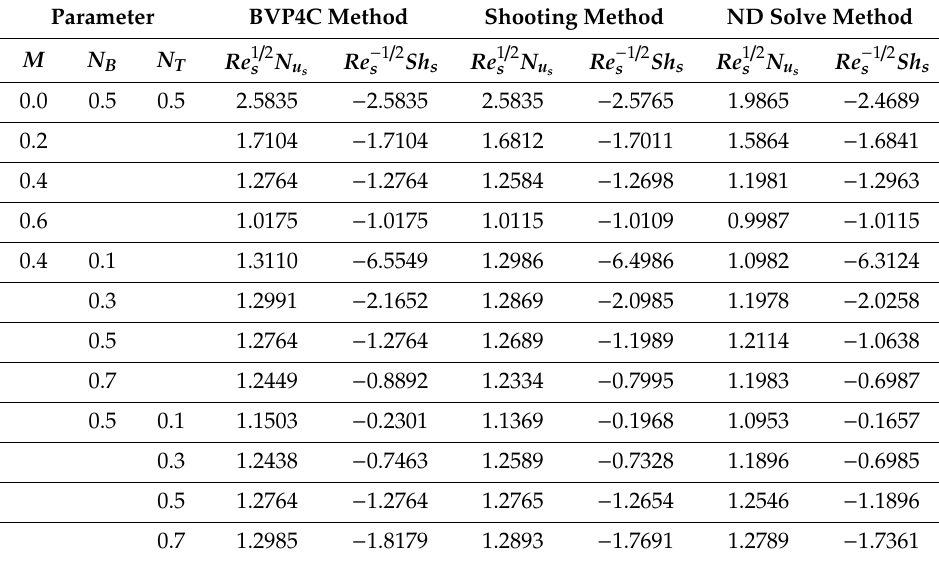
Table 2. Comparison equeaBVP4C with shooting method and ND solve